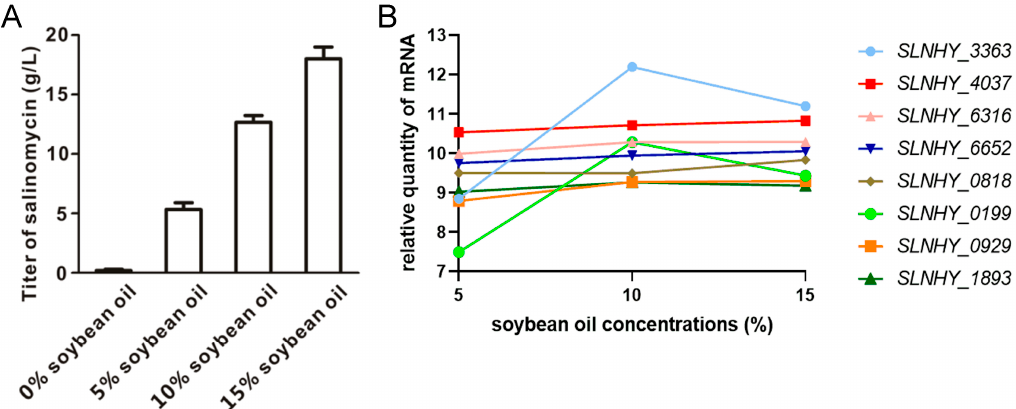
Figure 2. ( A ) Salinomycin titers under 0, 5, 10, and 15% soybean oil supplementation. ( B ) Transcription profiles of eight candidate transporter genes under 5, 10, and 15% ( w / v ) soybean oil supplementation.